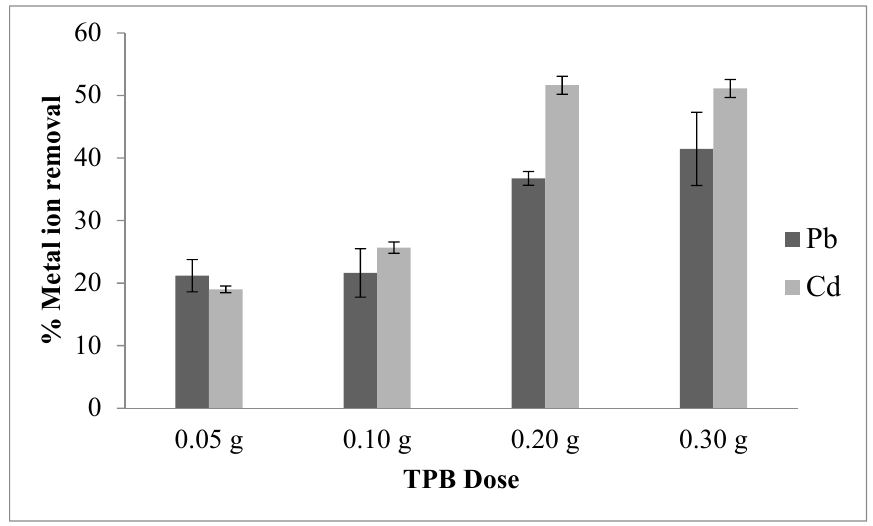
Figure 6. Effect of powdered biomass dose (0.212–0.50 mm) on metal ion removal (mean ± RSD) (50 mL, 50 ppm, pH 4) (120 rpm, 60 min, 25 °C). Each measurement has been done in triplicate.